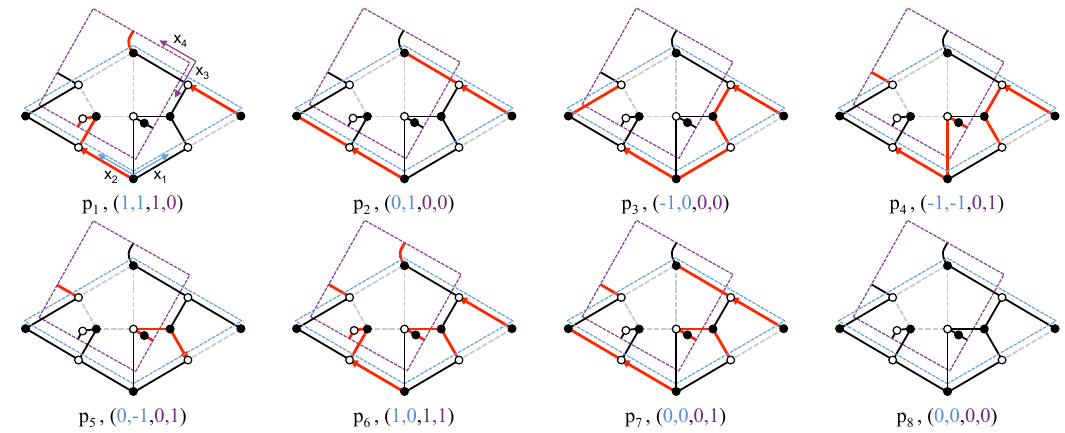
Figure 31. Cycles for the surviving perfect matchings using p 8 as